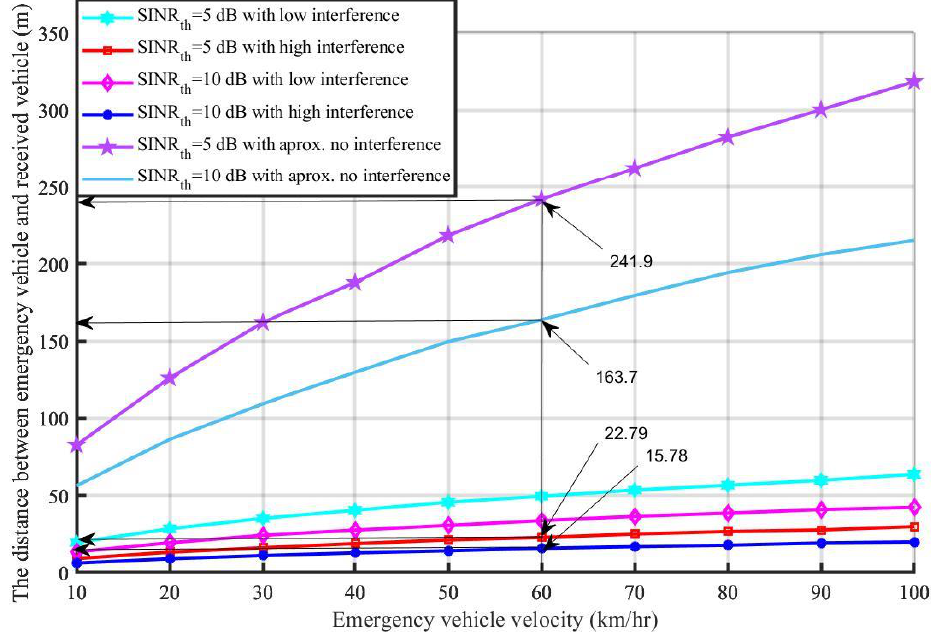
Figure 4. The distance between the emergency vehicle and the receiving vehicle versus the emergency vehicle ’s velocity.